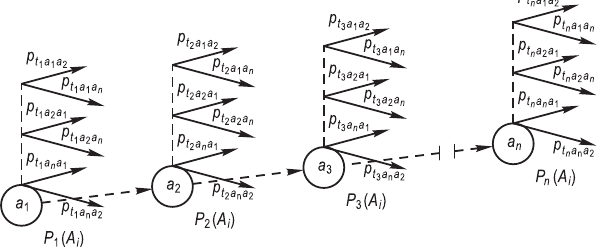
Fig 5. Fragment of network model of choosing alternatives